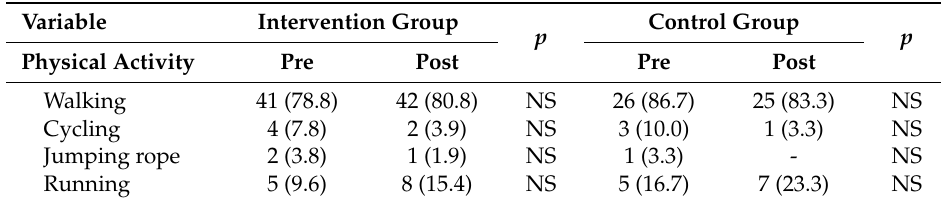
Table 3. Type of physical activity done most